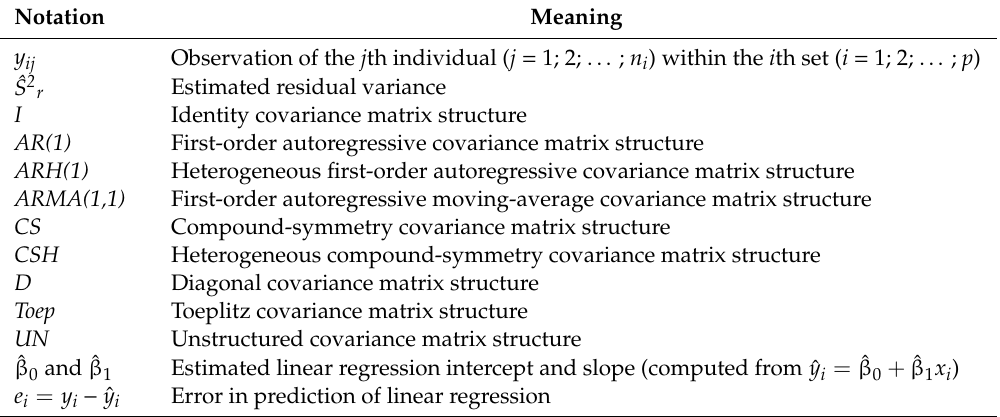
Figure 2. ( a ) Cross sections of where velocity measurements were made inside the tank (dimensions in mm); ( b ) Velocity measurement points within each of the four sections. Table 1. General terminology notation.